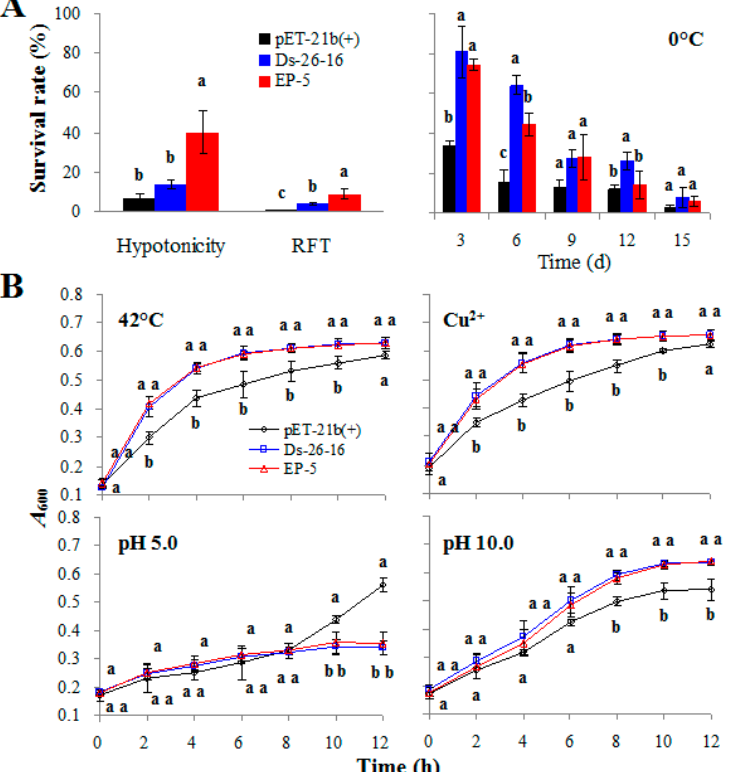
Figure 2. Characteristics of EP-5 to abiotic tolerance other than salt tolerance. ( A ) The survival rate of pET-21b(+), Ds-26-16 and EP-5 after hypotonicity and repeated freezing treatment (RFT); ( B ) The growth status of pET-21b(+), Ds-26-16 and EP-5 under various abiotic stresses, respectively. a, b or c stands for the significant differences ( p < 0.05) between the strains under the same stress at the same growth time ( p < 0.05).